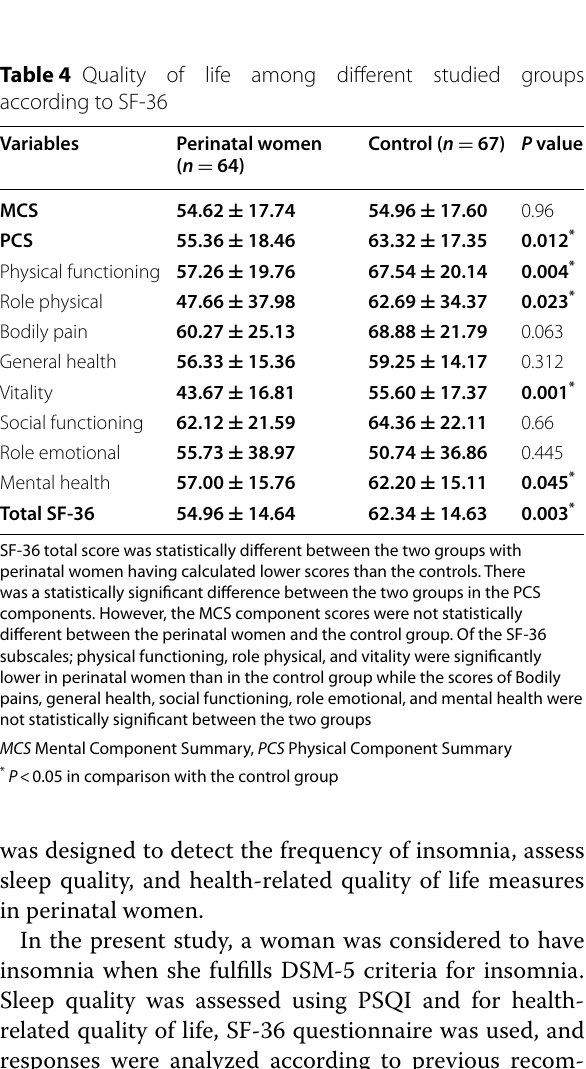
Table 3 Quality of sleep in the studied groups using the PSQI